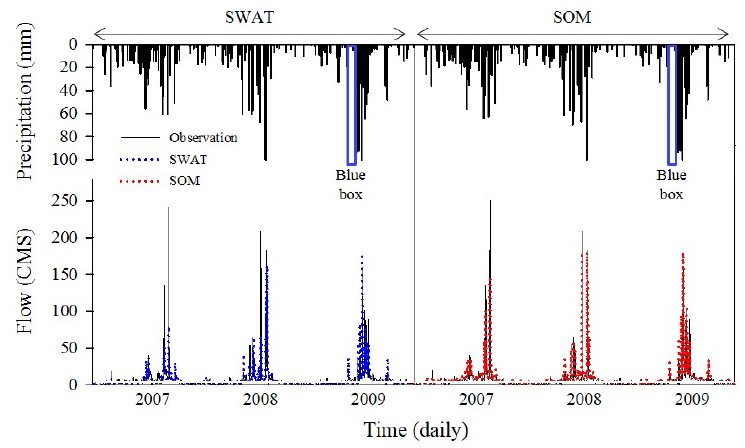
Figure 6. Comparison of daily performances between SWAT and SOM from 2007 to 2009 with regard to precipitation. Table 5. R 2 of SWAT and SOM from 2007 to 2009.